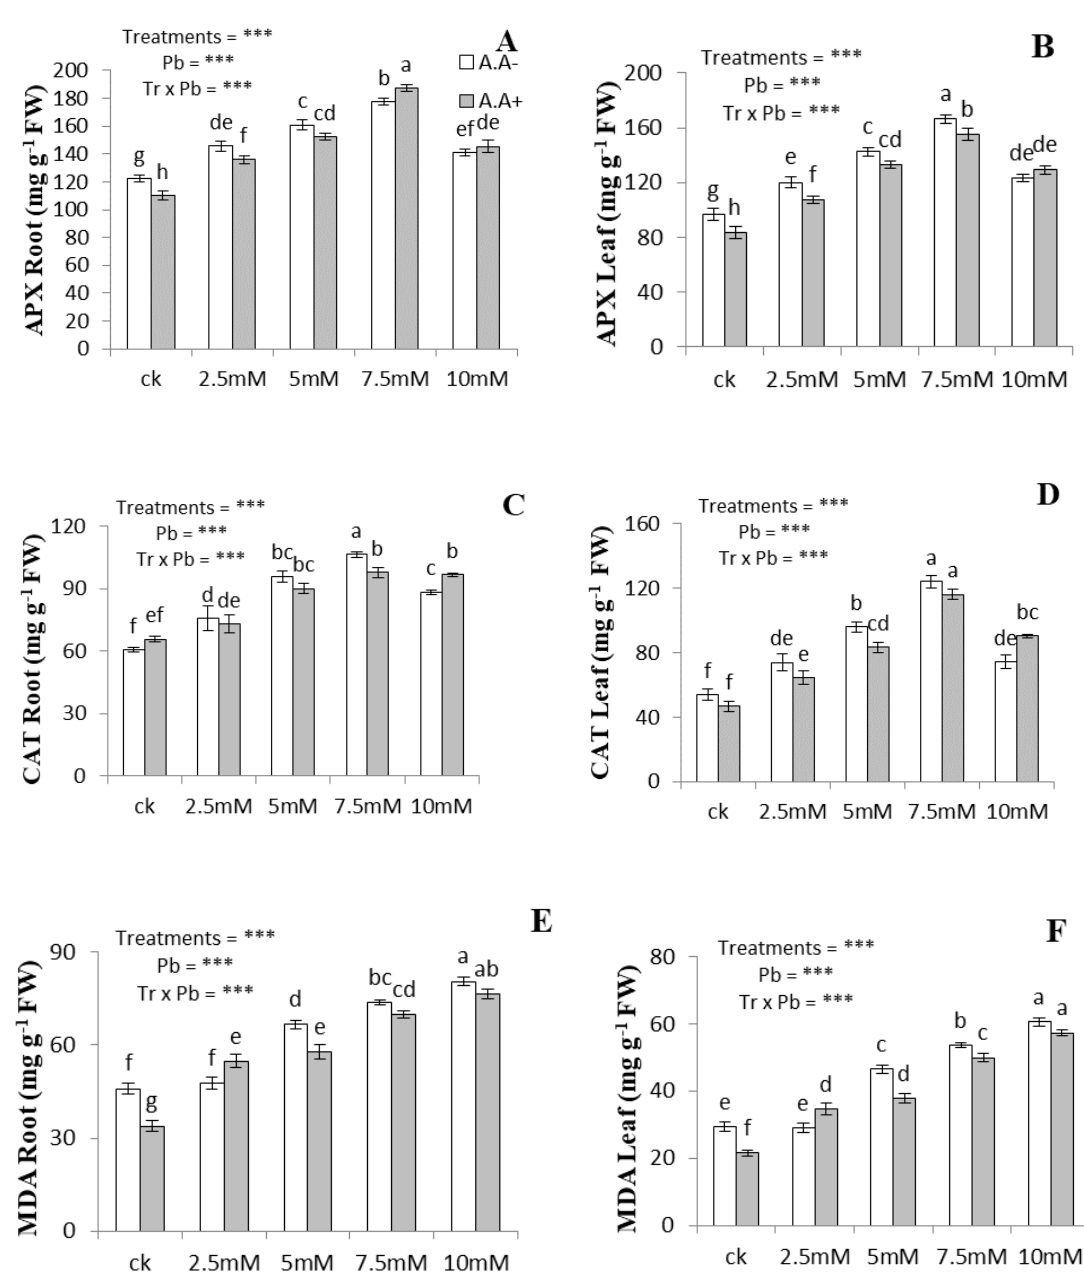
Figure 2. E ff ect of Pb and AA on APX in roots ( A ), APX in leaves ( B ), CAT in root ( C ), CAT in leaves ( D ), MDA in root ( E ) and MDA in leaves ( F ) of A. bettzickiana grown in soil with increasing Pb concentrations (0, 2.5, 5, 7.5 and 10 mM) and AA (0 and 2.5 mM). Values are mean of three replicates ± S.D. Di ff erent lowercase letters indicate significant di ff erences between treatments at p < 0.05; and *** indicate significance at the p < 0.01 level.